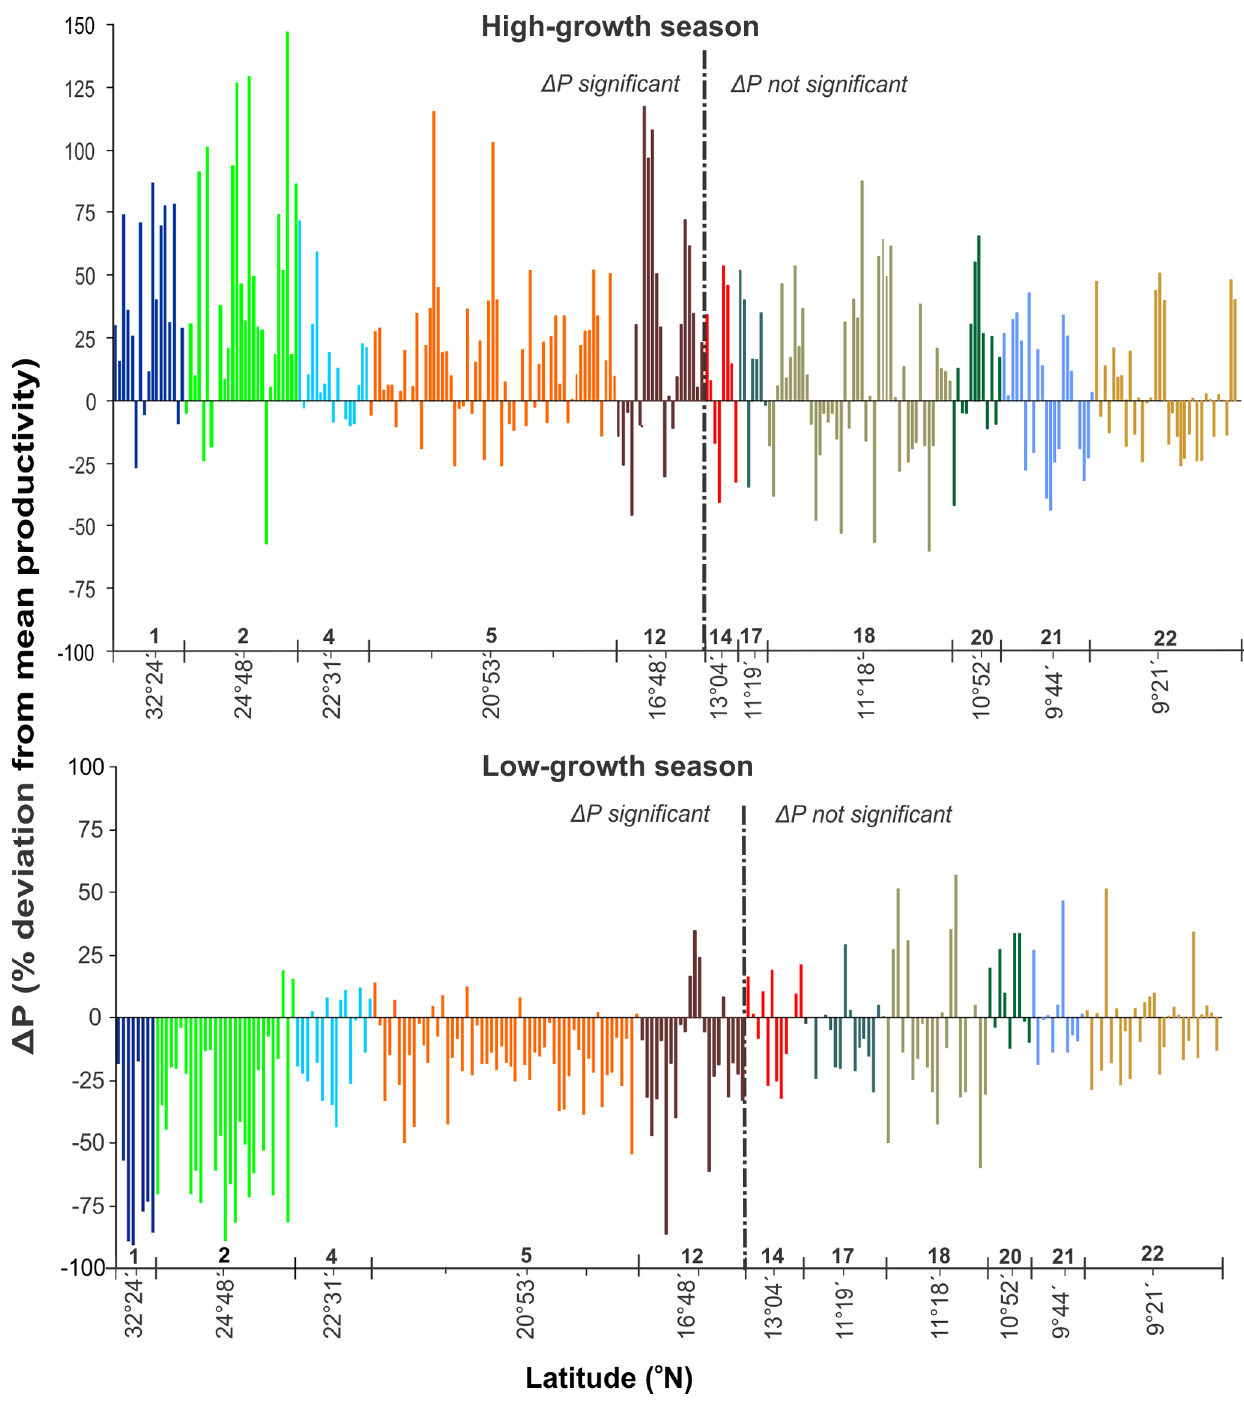
Figure 4. Deviations from general mean leaf productivity ( D P) of Thalassiatestudinum per station during High growth season (May- September at site 1 and 2, March –August at all other sites) and Low growth season (October-April at sites 1 and 2, September- February at all other sites). See Table S4 for significance differences of D P. Only stations with at least 10 sampling events were included. Numbers above the X-axis indicate site number, and the minor ticks indicate the different sampling stations at those sites.